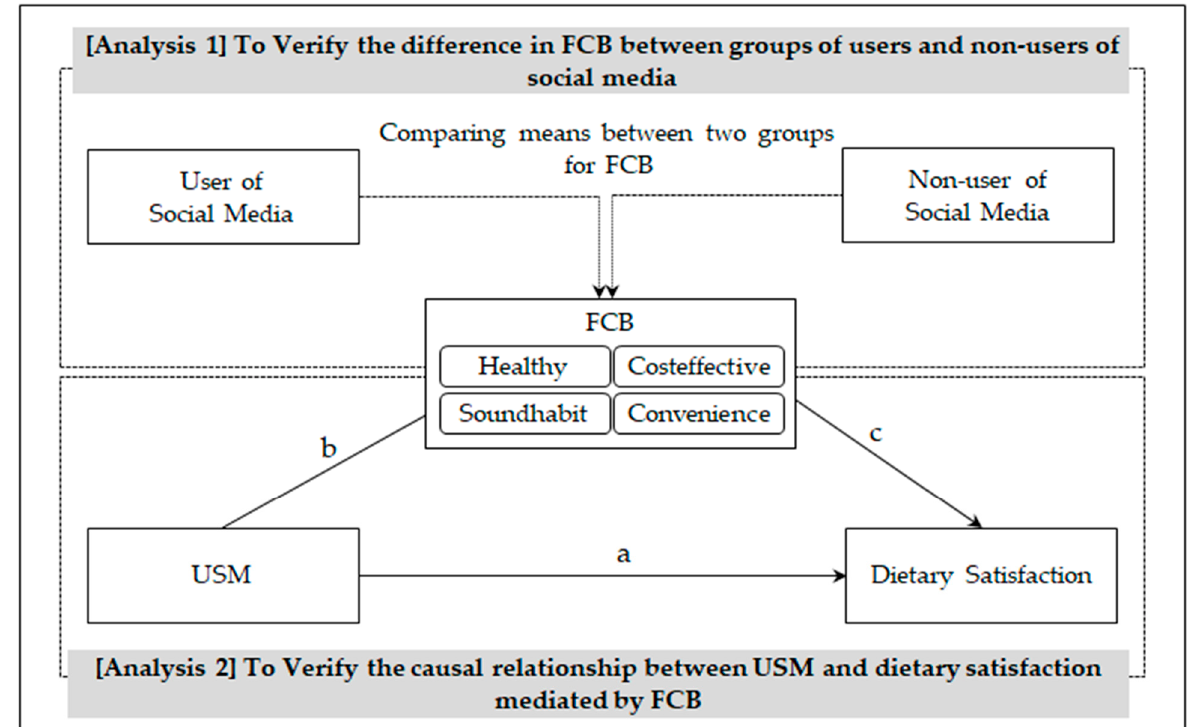
Figure 1. Overall research outline. Note: Healthy refers to the FCB of considering a consumer’s health; Costeffective refers to the FCB of valuing cost-effective consumption; Soundhabit refers to the FCB of keeping sound eating habits; Convenience refers to the FCB of preferring convenience; “a” refers to a direct path from USM to Dietary Satisfaction, “b” and “c” are indirect paths from USM to Dietary Satisfaction.